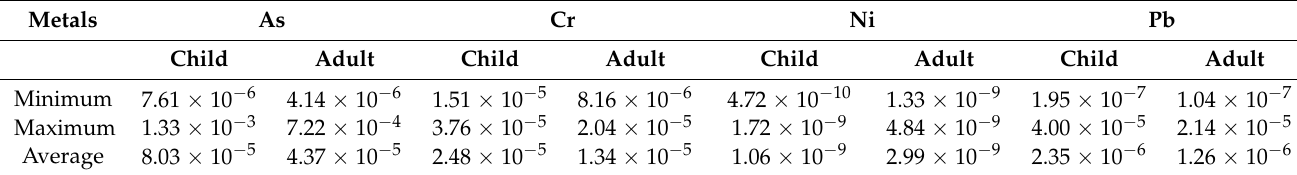
Table 6. Total carcinogenic risk (TCR) from As, Cr, Ni, and Pb in adults and children. Metals As Cr Ni Pb Child Adult Child Adult Child Adult Child